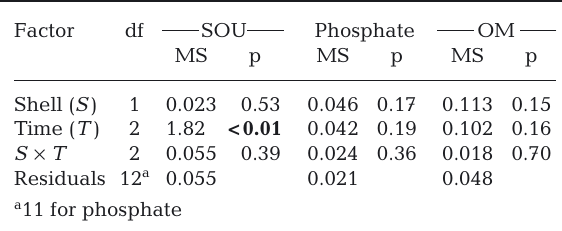
Table 3. ANOVA of the change in weight of polychaetes and number of holes created by the polychaetes as function